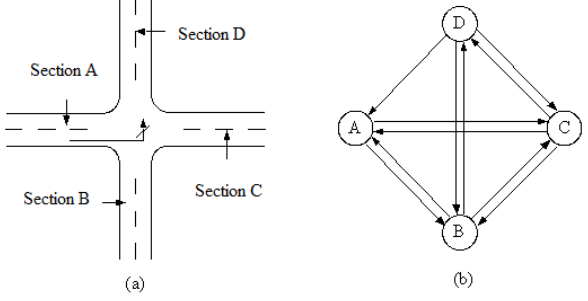
intersectionsFig.2 Schematic diagram for road intersection representation by using the method to transform road